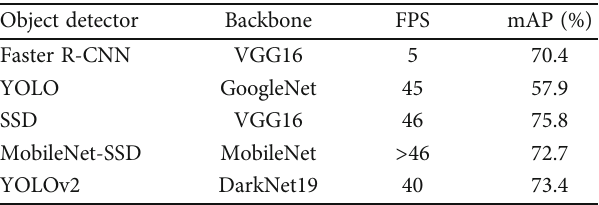
Table 1: Performance of common target detection algorithms on VOC2012